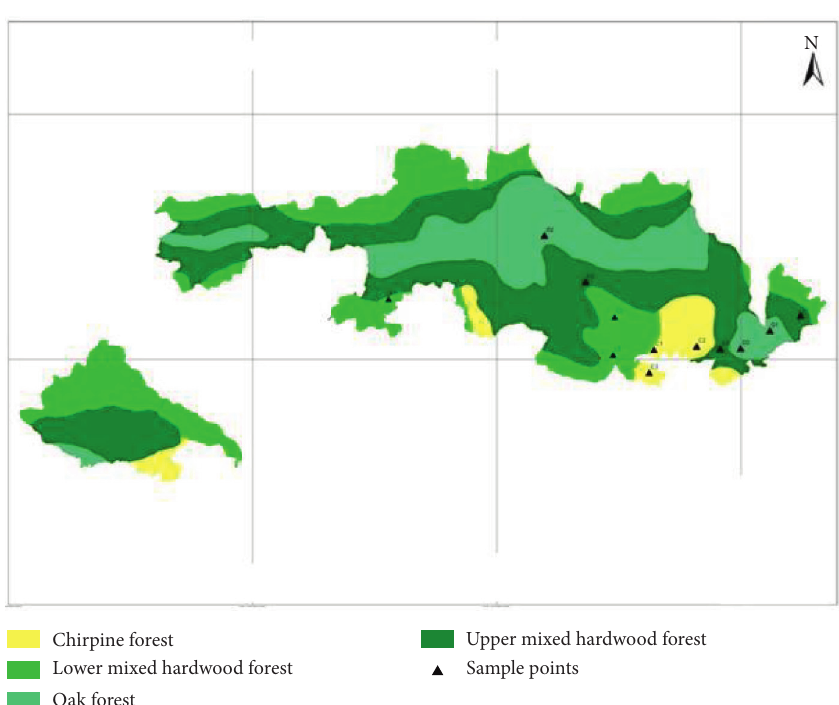
Figure 2: Vegetation map showing forest types of SNNP and sample